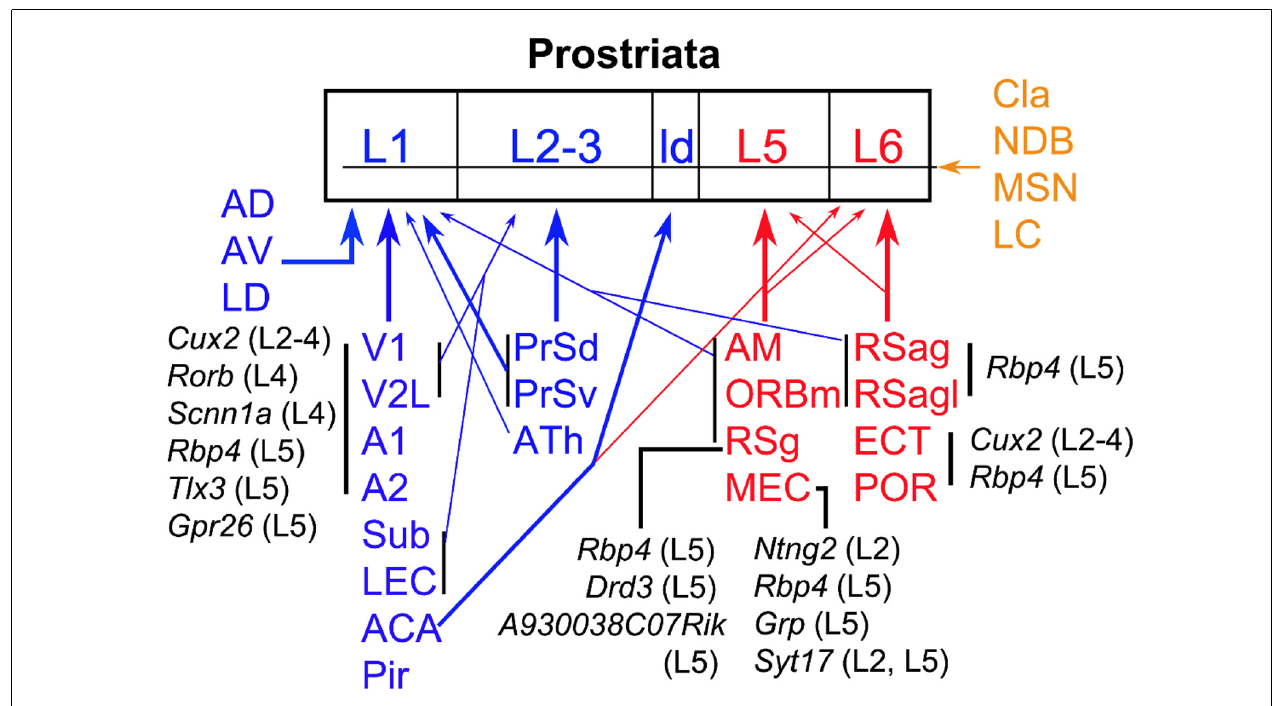
FIGURE 12 | Summary of afferent projections of the prostriata. The regions sending afferents to the Pro are coded blue (to superficial layers), red (to deep layers), and brown (to all layers). Thick and thin arrows indicate moderate/strong and weaker projections, respectively. The cells of origin and their locations/layers in major cortical regions are in black. The cell types that originate the projections to the Pro in specific cortical regions are represented by the genes they express while their laminar locations are indicated in the brackets. For example, Rbp4 (L5) means Rbp4 expressing neurons in layer 5; it also indicates that the Cre-driver line Rbp4 -Cre_KL100 was used in this study to determine the projections (for details see text). ATh, anterior midline thalamic region.